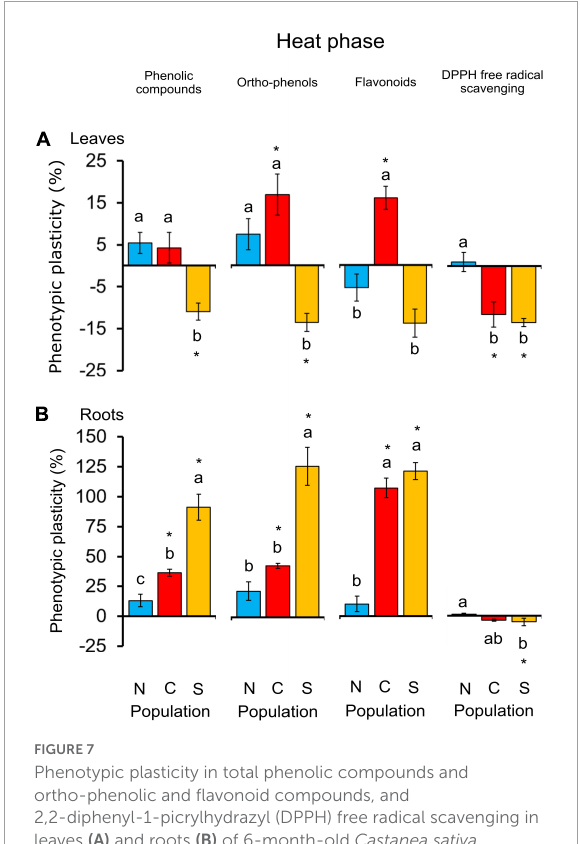
FIGURE7 Phenotypic plasticity in total phenolic compounds and ortho-phenolic and flavonoid compounds, and 2,2-diphenyl-1-picrylhydrazyl (DPPH) free radical scavenging in leaves (A) and roots (B) of 6-month-old Castanea sativa seedlings from the northern, central, and southern populations in Spain (N, C, and S, respectively) after they were subjected to heat stress for 7 days. Heat treatment effects are shown in percentages relative to the values obtained for control plants. Vertical lines indicate standard errors of the mean ( n = 6). Asterisks indicate significant differences from the control treatment (Tukey’s HSD test, P < 0.05). Different letters indicate different significant effects between populations within each variable (Tukey’s HSD test, P <